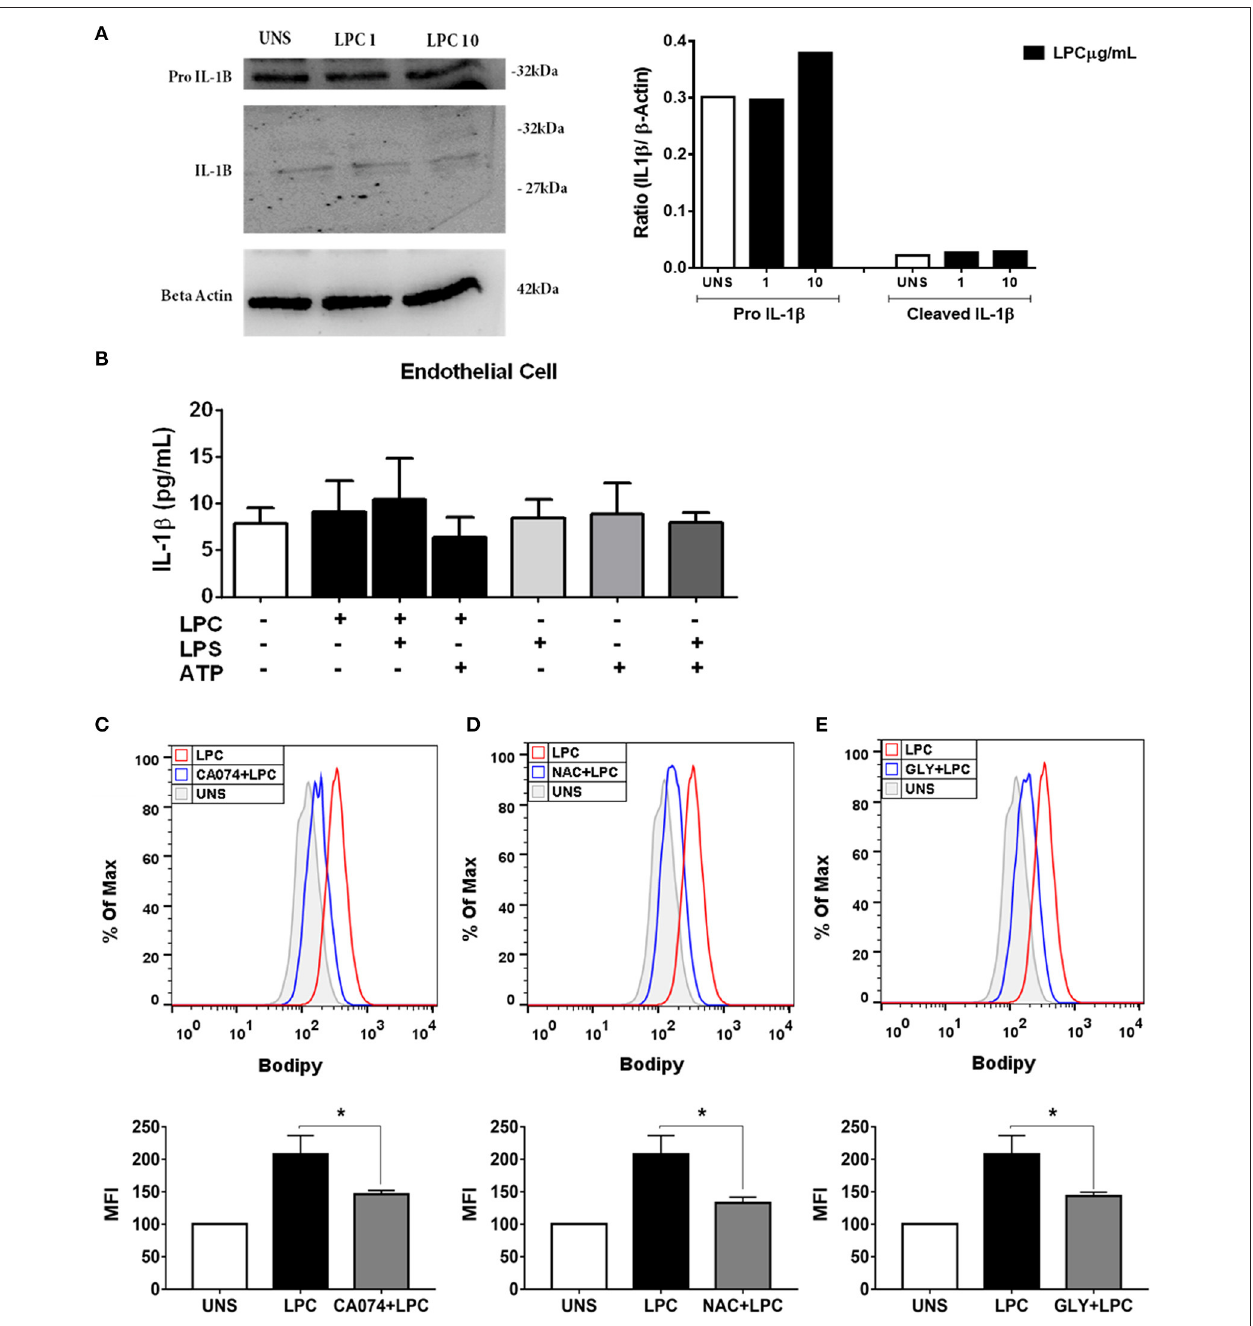
FIGURE 5 | Lysophosphatidylcholine (LPC) induces foam cell formation mediated by an inflammasome-dependent pathway in human endothelial cells. Human endothelial cells were stimulated with 1 and 10 µ g/ml of LPC. After 24h, the protein levels of (A) pro–IL-1 β and IL-1 β in the supernatants or cell lysates were examined by western blot analysis. Beta actin was used as an internal control. Human endothelial cells (B) were pretreated with LPS (500ng/ml) 4h before treatment with 1 µ g of LPC for 24h. After this time, the cells were treated with ATP (1mM). One hour later, the supernatants were collected, and the levels of IL-1 β were measured by ELISAs. The bar graph represents one experiment performed twice in triplicate. In addition, human endothelial cells were pretreated with different inhibitors: (C) cathepsin B inhibitor (CA-074), (D) reactive oxygen species (ROS) inhibitor ( N -acetyl- L -cysteine [NAC]), and (E) inhibitor of potassium efflux [glibenclamide (GLY)] for 1h and stimulated with 1 µ g of LPC for 24h. Lipid droplets were stained with BODIPY and analyzed by flow cytometry. Histograms are representatives of three independent experiments. Each bar graphic represents the mean fluorescence intensity (MFI), and bars show significant differences and represent the 95% confidence interval (* p < 0.05) of the cells stimulated with LPC or UNS (unstimulated cells).